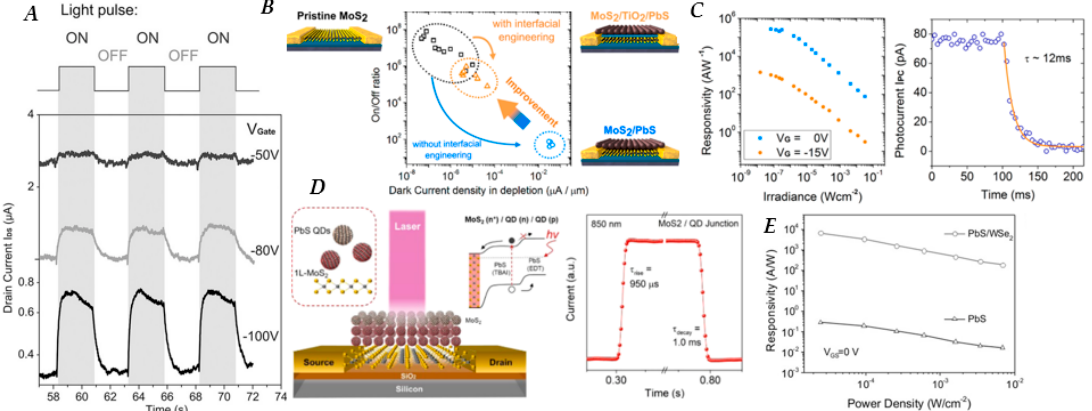
Figure 6. ( A ) Photocurrent response of hybrid molebdynum disulfide (MoS 2 )-PbS QD phototransistor as a function of time at various, relatively high gate voltages ( V DS = 1 V, irradiance 3 µW/cm 2 ). ( B ) Schematics of bare MoS 2 phototransistor as well PbS QD/MoS 2 phototransistor with and without titanium(IV) oxide (TiO 2 ) buffer layer; label colors correspond with points on the graph. Graph shows on/off ratio as a function of dark current density, demonstrating that a TiO 2 buffer layer helps to reduce dark current. ( C ) [Right] Responsivity as a function of irradiance for hybrid MoS 2 -PbS QD device with a TiO 2 buffer layer at different gate voltages ( V DS = 1 V). [Left] Photocurrent decay time of a light response at 67 nW/cm 2 ; the approximation with a single-exponential function results in a time constant of 12 ms. ( D ) Schematic of hybrid MoS 2 -PbS QD devices using 1,2-ethanedithiol (EDT) and tetrabutylammonium iodide (TBAI) ligands to create a built in potential (energy-band diagram inset), and [right] response time of device under laser 850 nm laser illumination ( P = 200 nW, V DS = 1